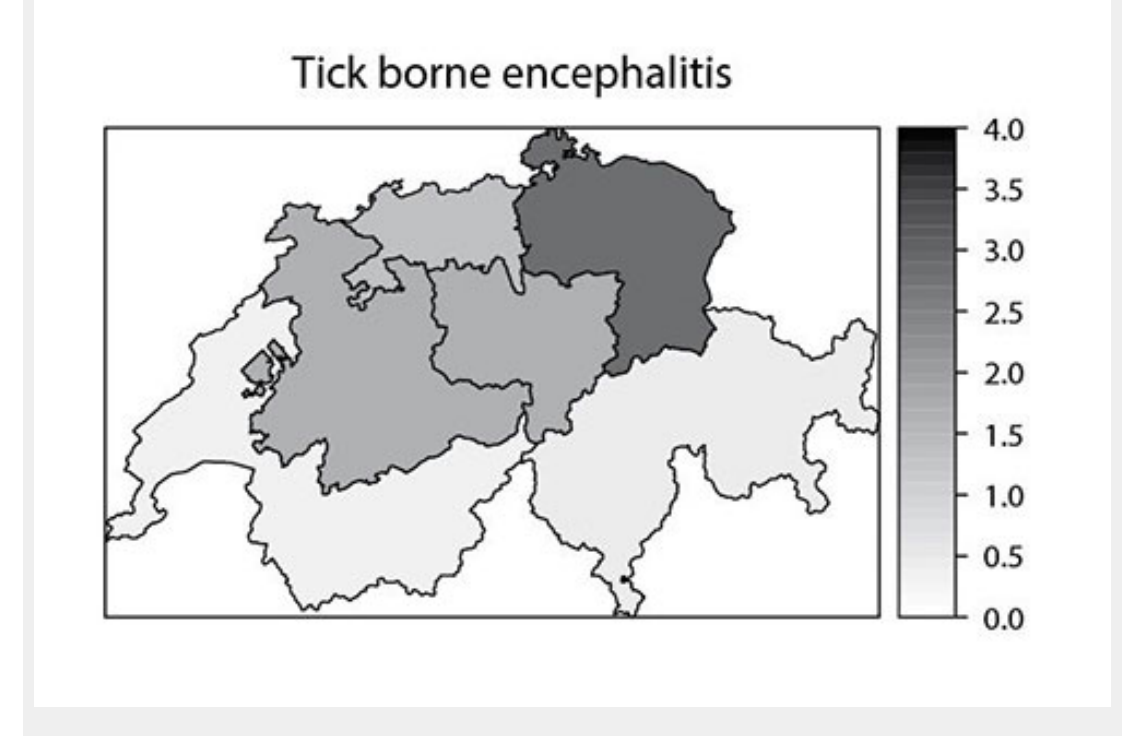
Figure 1 Geographic distribution by Sentinella Regions regarding treated tick bites, Lyme borreliosis and tick borne encephalitis, Switzerland 2008 to 2011. Panel 3: Tick borne encephalitis, yearly incidence per 100,000 inhabitants,